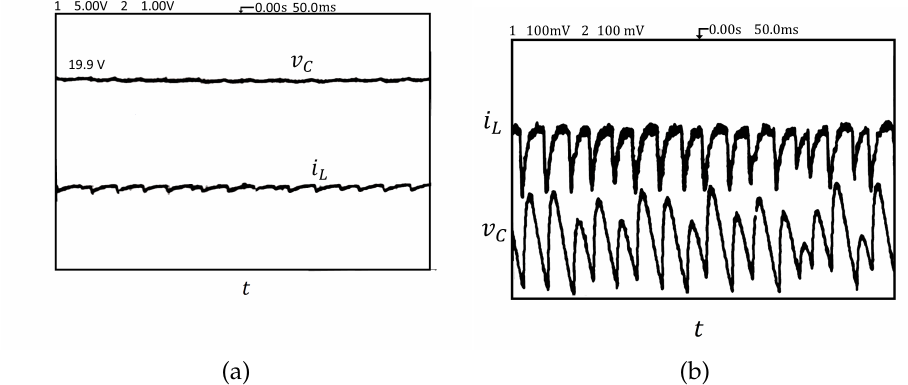
Figure 23. Experimental chaotic dynamics with the zero hysteresis control due to existence of residual hysteresis created by physical limitations and internal parasitic effects of electronic components: ( a ) DC voltage output and inductor currrent and ( b ) AC signals showing the variable ripple on voltage and current.